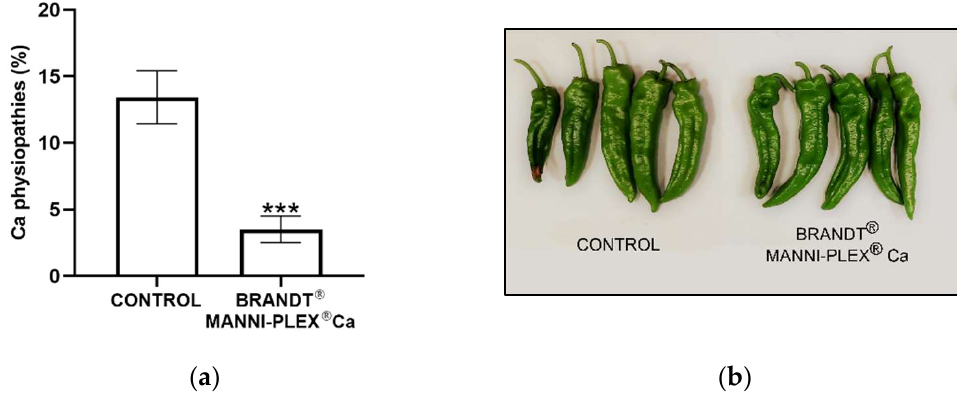
Figure 2. Effect of BRANDT ® MANNI-PLEX ® Ca application on the percentage of fruits with physiopathies related to Ca deficiency ( a ) and photography showing the appearance of pepper fruits ( b ). Values are expressed as means ± standard error ( n = 9). The level of significance was represented by p < 0.001 (***).